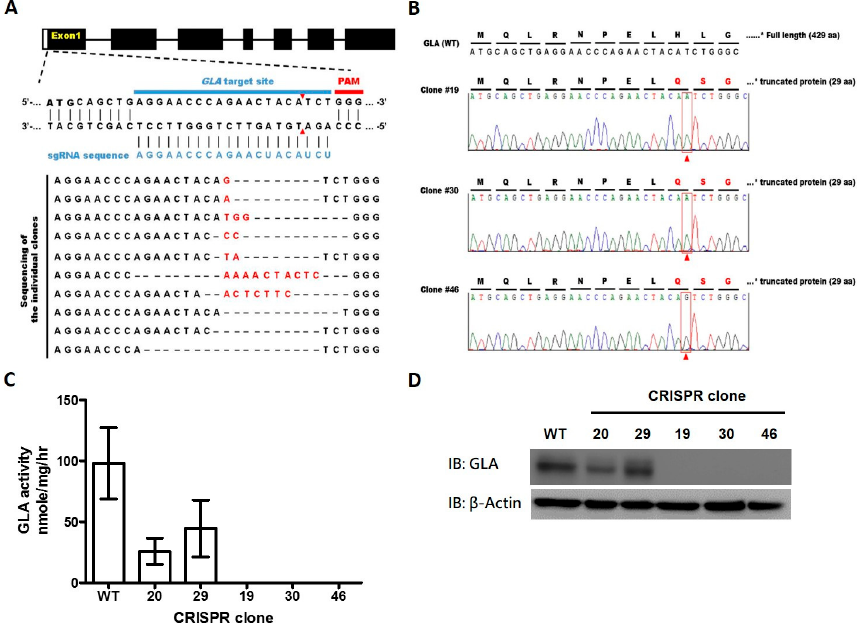
Figure 1. CRISPR/Cas9-mediated genome disruption of human GLA results in cell lacking detectable GLA expression. ( A ) The sgRNA sequence for GLA gene targeting and the mutation spectra of GLA gene was illustrated. The sgRNA sequence (5 (cid:48) -AGGAACCCAGAACUACAUCU-3 (cid:48) ) was labeled as blue. Sequence within the blue bar- and red bar-labeled range indicated the GLA target site of sgRNA and the upstream protospacer adjacent motif (PAM), respectively. The double-strand breaking site was indicated as the red arrowheads. The indel spectrum of each clone was shown in alignment, in addition, the black texts, red texts, and dash represented the original GLA sequence, inserted nucleotide, and deleted nucleotide/alignment space, respectively in the GLA target site; ( B ) Sequence analysis confirmed the mutations with one nucleotide insertion (indicated by red arrowhead in red square) in the selected GLA-null cell lines, i.e., clone 19, 30, and 46, in comparison with the wild-type (WT) human GLA sequence. The GLA enzyme activities ( C ) and the GLA protein expressions ( D ) were determined in the parental HEK-293T cells and the selected GLA-null cell